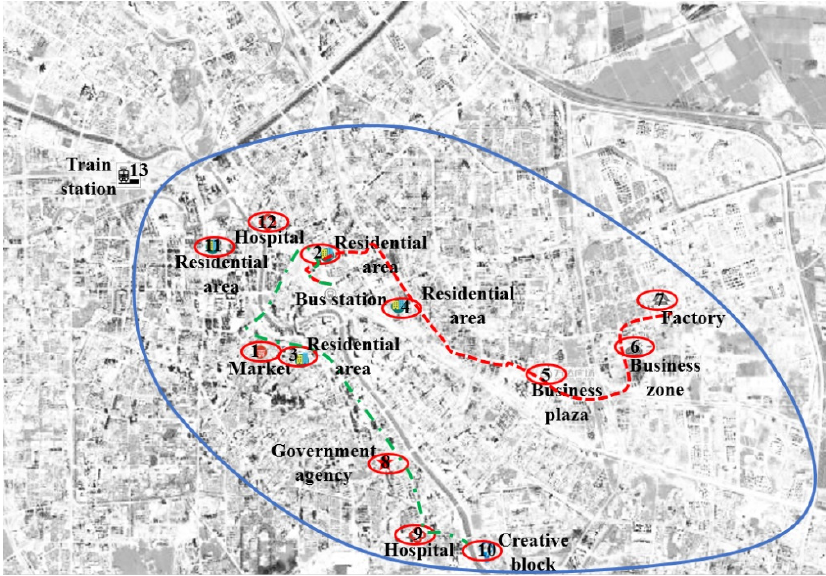
Figure 3. Results of the cluster analysis.